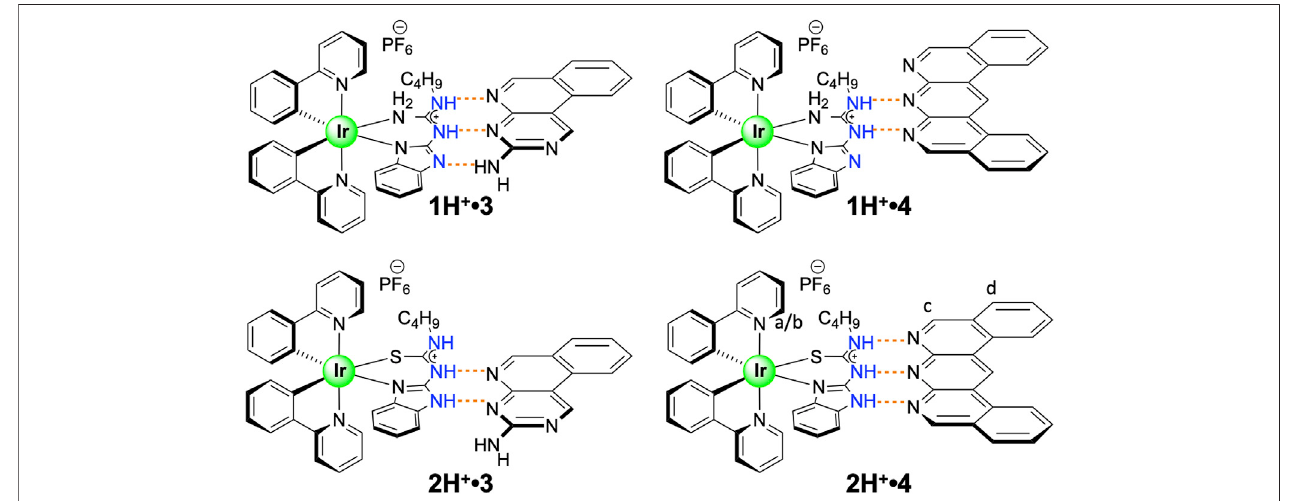
FIGURE 1 | Four complementary charge-assisted H-bonding systems featured in this study.